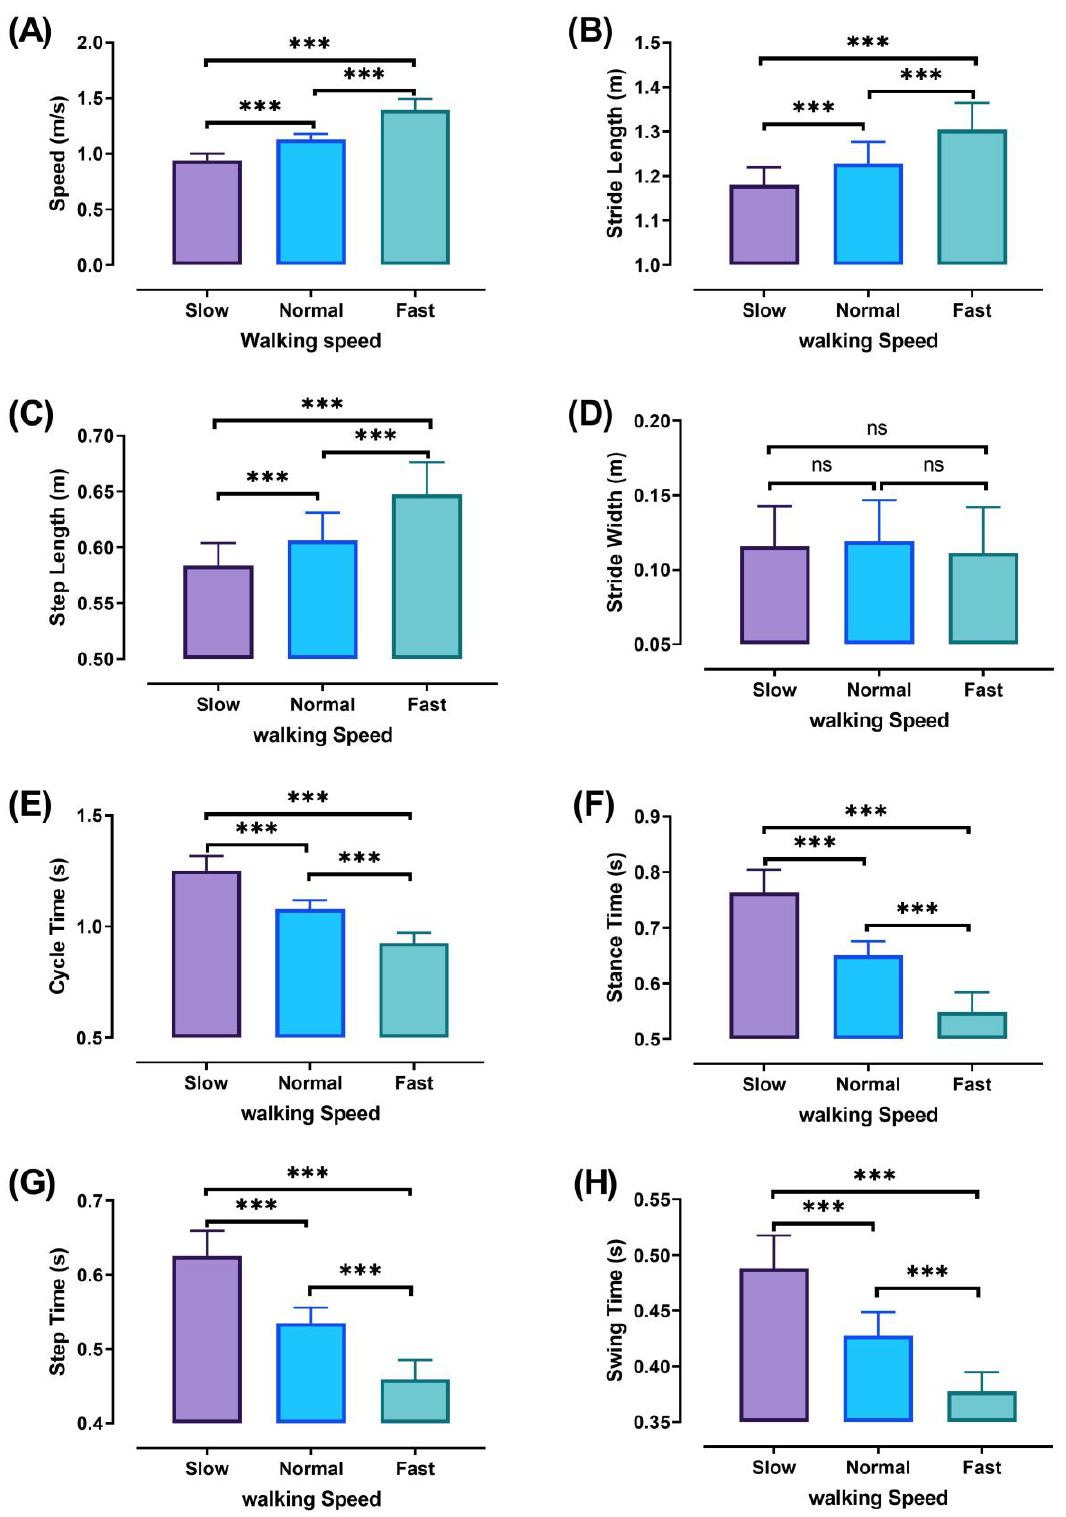
Figure 5. Walking characteristics at different speeds (Slow, Normal, and Fast). walking speed ( A ), stride length ( B ), step length ( C ), stride width ( D ), cycle time ( E ), stance time ( F ), step time ( G ), and swing time ( H ). ANOVA results showing the differences of walking characteristics during walking speed (Slow, Normal, and Fast). Asterisk signs above the line represent significant differences between walking speeds: (***) indicates p < 0.001, and (ns) indicates non-significant.